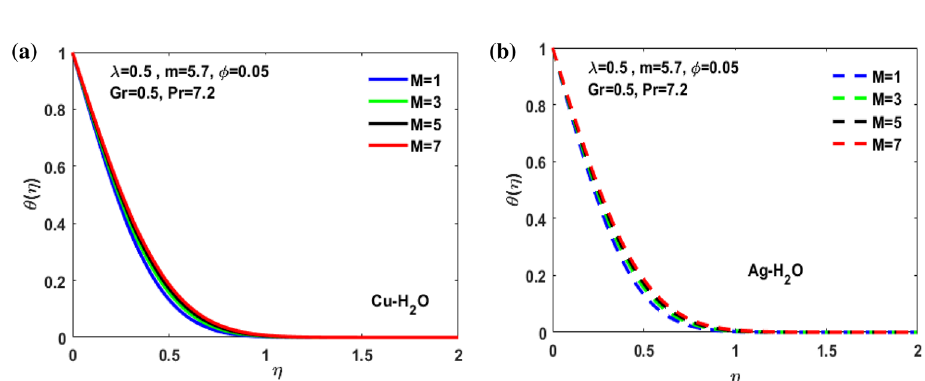
Figure 10. ( a ) Variation of M on θ(η) . ( b ) Variation of M on θ(η) .